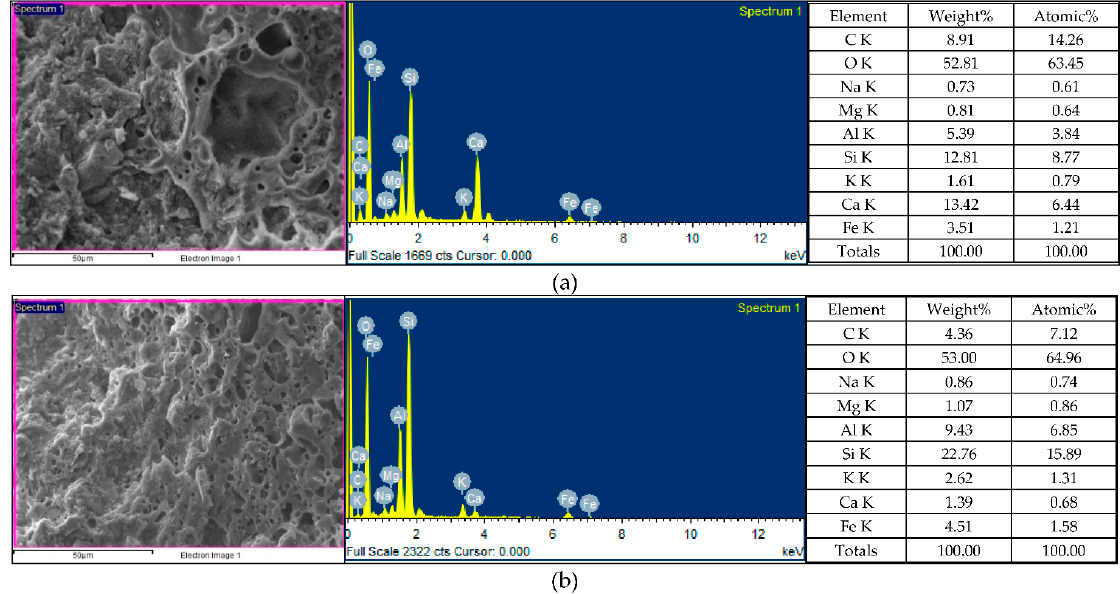
Figure 14. EDS analysis of the concrete specimens after self-healing for 28 days: ( a ) control group; ( b ) experimental group.